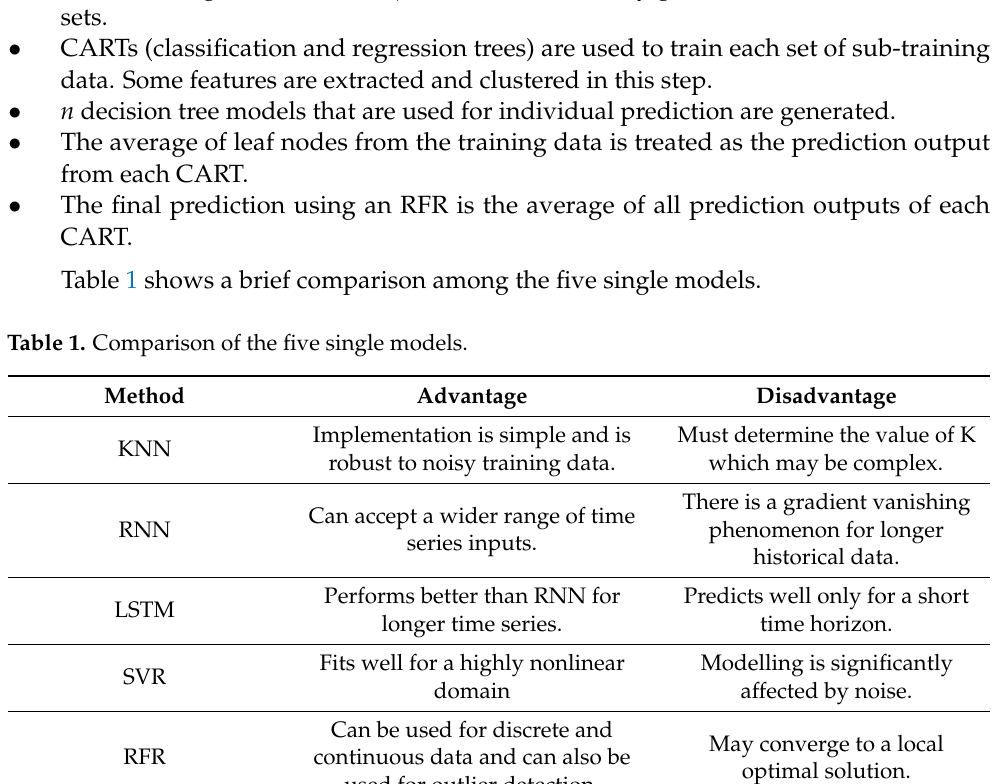
Must determine the value of K which may be complex. There is a gradient vanishing phenomenon for longer historical data. Predicts well only for a short time horizon. Modelling is significantly affected by noise. May converge to a local optimal